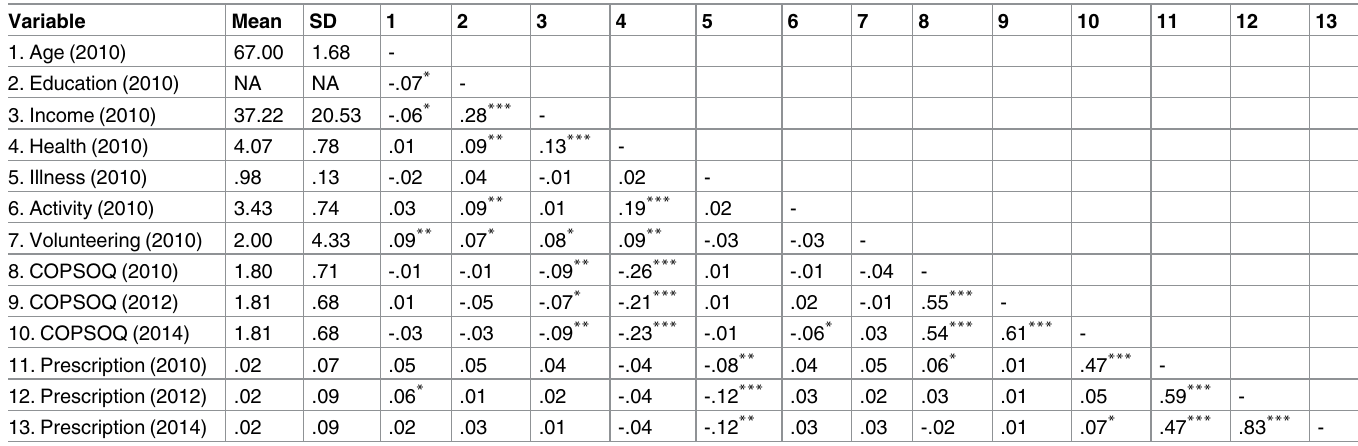
The estimated normal causation path model. Table 2 reports the standardized path coef- ficients of the amount of hours spent volunteering in 2010 (discontinuous and continuous) on one’s cognitive complaints and the likelihood of being prescribed an anti-dementia treatment in 2012 and 2014. Results reflect controlling for the above-mentioned background variables and baseline self-reported cognitive complaints and prescribed anti-dementia medication (i.e., previous levels of these outcome variables).